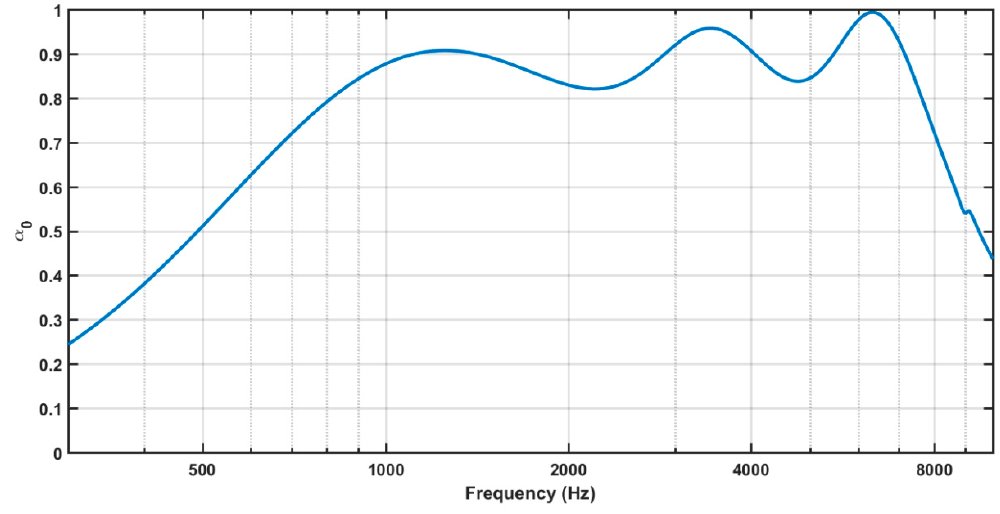
Figure 27. Normal incidence absorption coefficient of a TL-MPP with parameters ( d 1 , t 1 , φ 1 , D 1 , d 2 , t 2 , φ 2 , D 2 , d 3 , t 3 , φ 3 , D 3 ) = (0.15 mm,1.35,15%,0.89 cm,0.15 mm,1.4 mm,10%,1.3 cm,0.15 mm,1.1 mm,5%,2 cm).